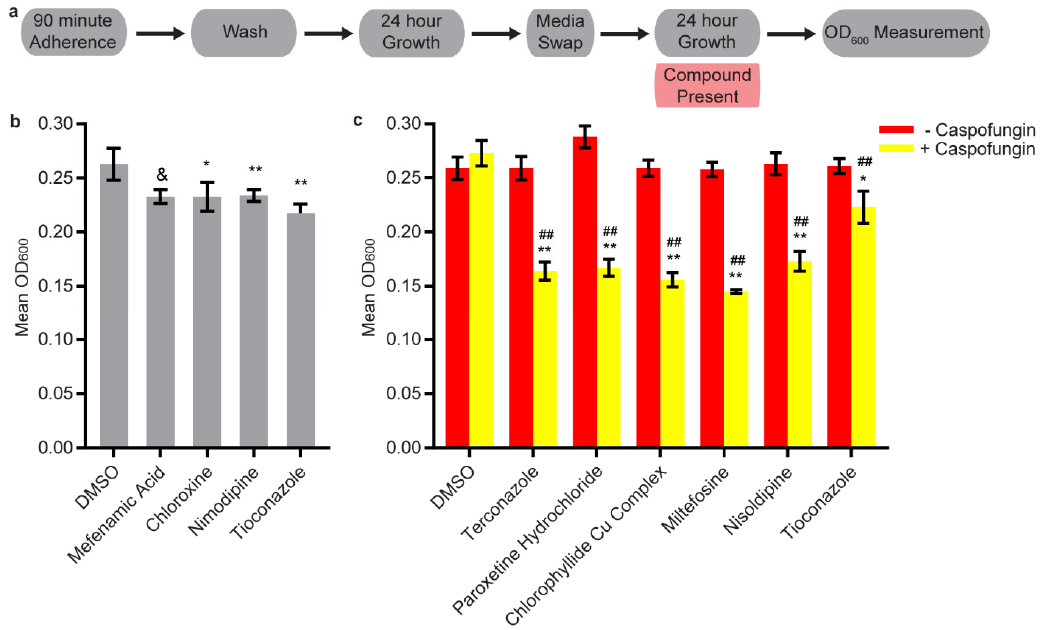
Figure 3. Fourteen candidate compounds disrupted mature biofilms by themselves or in combination with the known antifungal agent caspofungin. ( a ) Overview of the disruption optical density biofilm assay used for these experiments. In brief, the media was removed after the 24-h growth step and fresh media containing the compound was added, after which biofilms were grown in vitro for an additional 24 h. ( b ) Subset of the statistically significant hits from the stand-alone disruption optical density biofilm assay. Mean OD 600 readings with standard deviations are shown, significant differences from the DMSO solvent control as determined by Welch’s t -test (two-tailed, assuming unequal variance) with the Bonferroni correction are indicated for α = 0.05 (*), α = 0.01 (**), or mixed results (&). Although a single repeat is shown, the indicated significance threshold was met by all of the repeats of each compound shown with the exception of mefenamic acid. In that case, one of the four repeats did not pass either significance threshold while the remaining three repeats passed at α = 0.01. ( c ) Subset of the statistically significant hits from the combination disruption optical density biofilm assays with caspofungin. For each compound, the wells with caspofungin (+ caspofungin) are indicated in yellow and the wells without caspofungin (– caspofungin) are indicated in red. Mean OD 600 readings with standard deviations are shown; significant differences from the compound without caspofungin control (e.g., nisoldipine, – caspofungin), as determined by Welch’s t -test (two- tailed, assuming unequal variance) with the Bonferroni correction, are indicated for α = 0.05 (*) and α = 0.01 (**). Significant differences from the caspofungin without compound control (e.g., DMSO, + caspofungin), as determined by Welch’s t -test (two-tailed, assuming unequal variance) with the Bonferroni correction are indicated for α = 0.05 (#) and α = 0.01 (##). In both panels b and c, the data within a chart are all taken from the same plate on the same day. We next tested the 43 candidate compounds at 12.5 µM or lower concentrations (see methods